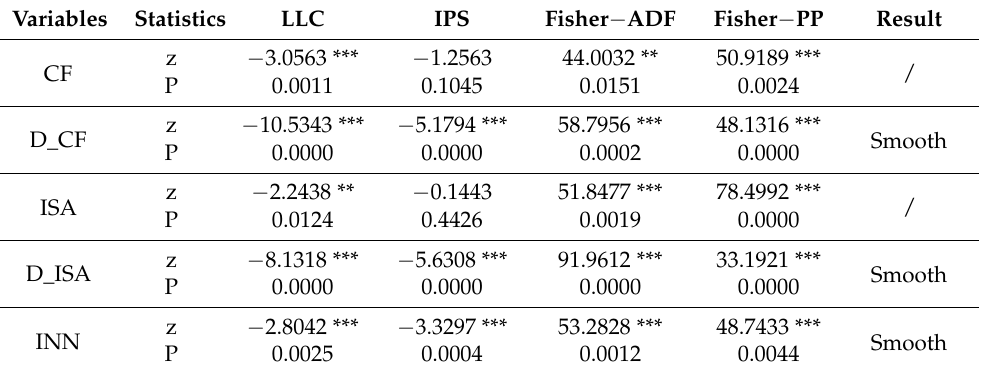
Table 3. Smoothing test.